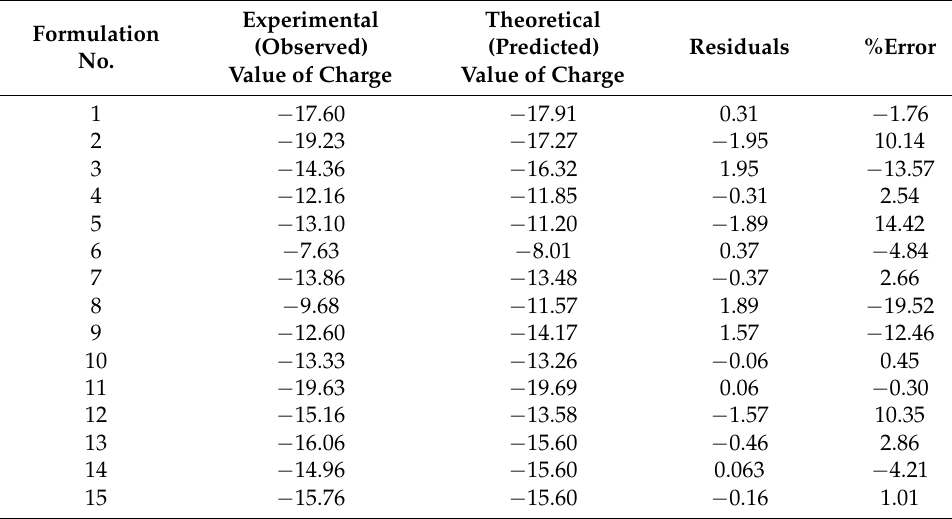
Table 9. Experimental and theoretical values with residuals of the response Y2.